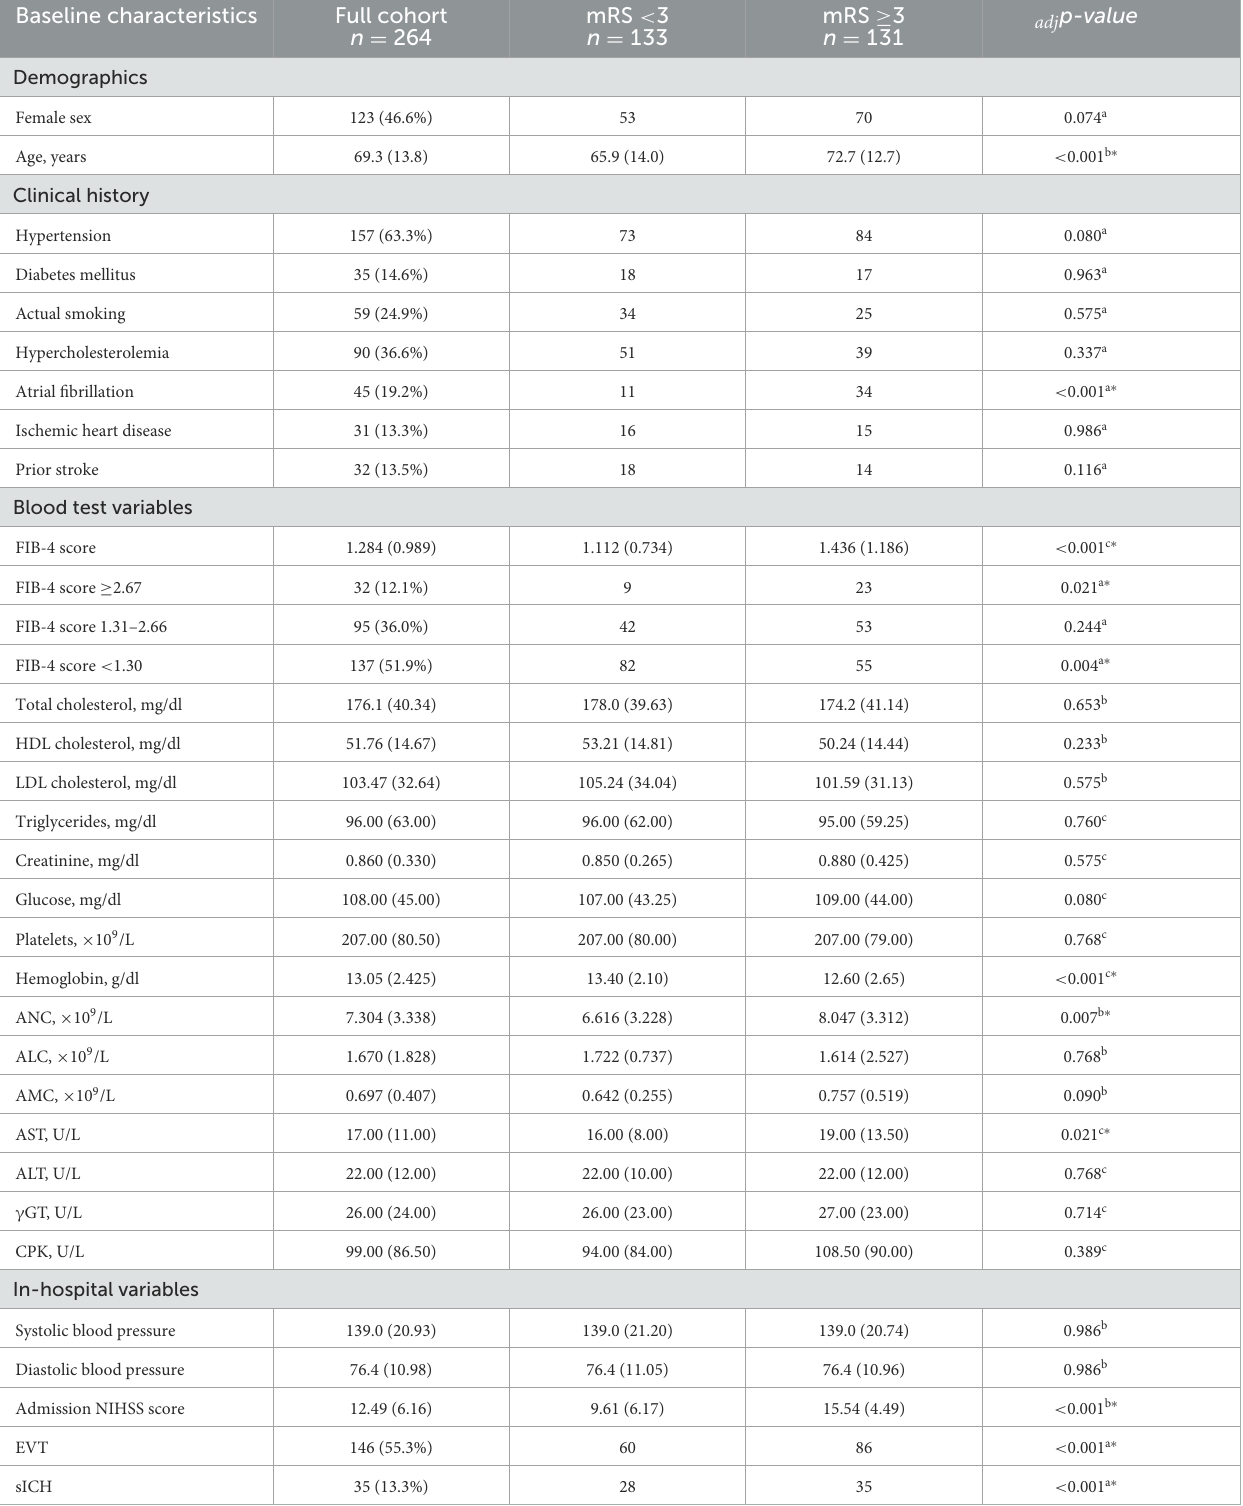
TABLE 1 Baseline characteristics according to the 3-month